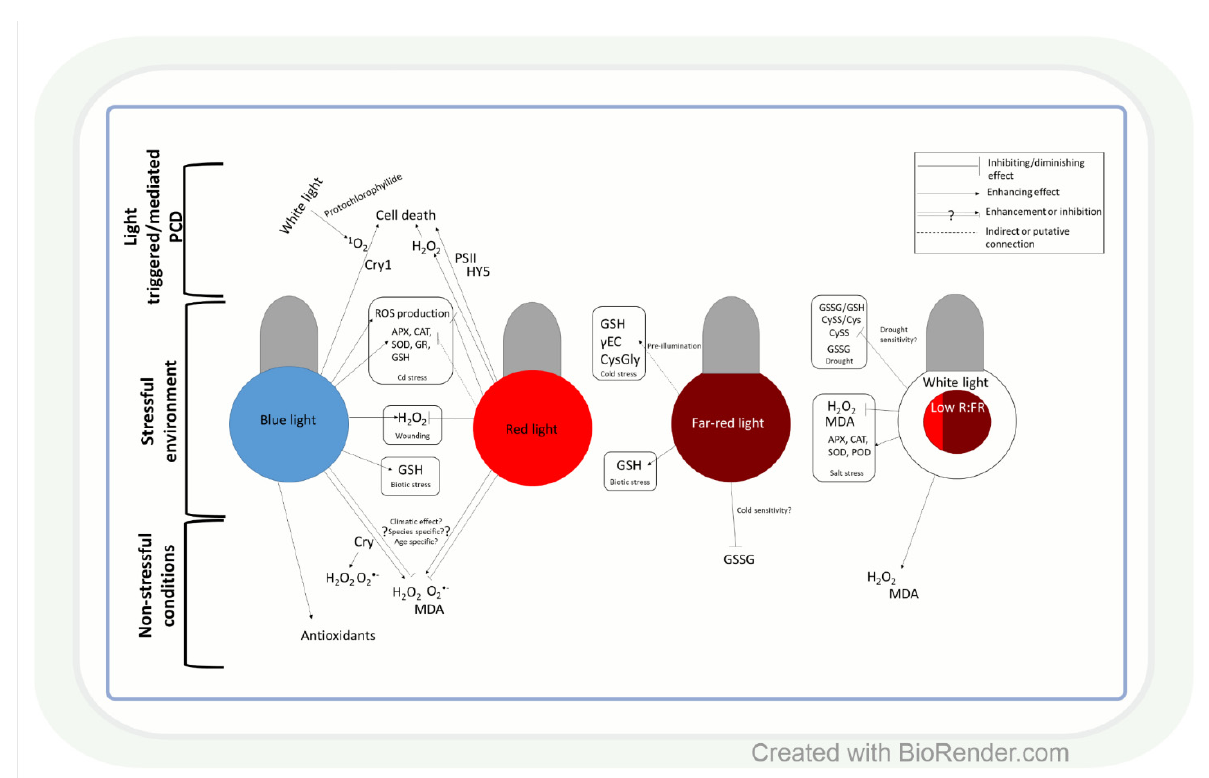
Figure 2. Influence of light quality on reactive oxygen species and antioxidants. Both blue and red light may act as an enhancer or a repressor of ROS accumulation, which is highly dependent on the origin (temperate or tropical climate) of the plant species, but other factors may also influence their effect on ROS. Generally, under stress conditions, blue light enhances ROS production, while red light diminishes it. ROS might have different roles in the cell death process caused by monochromic blue- or red-light illumination. The low red:far-red ratio (R:FR) exerts a beneficial effect on ROS homeostasis under stress. CRY: cryptochrome; MDA: malondialdehyde; PSII: photosystem II; HY5 elongated hypocotyl 5; SOD: superoxide dismutase; CAT: catalase; GR: glutathione reductase; GSH: reduced glutathione; APX: ascorbate peroxidase; POD: guaiacol peroxidase; γ EC: γ -glutamyl-cysteine; GSSG: glutathione disulphide; CySS: cystine; CysGly: cysteinylglycine; GSSG/GSH: glutathione disulphide/glutathione ratio; CySS/Cys: cystine/cysteine ratio; PCD: programmed cell death.